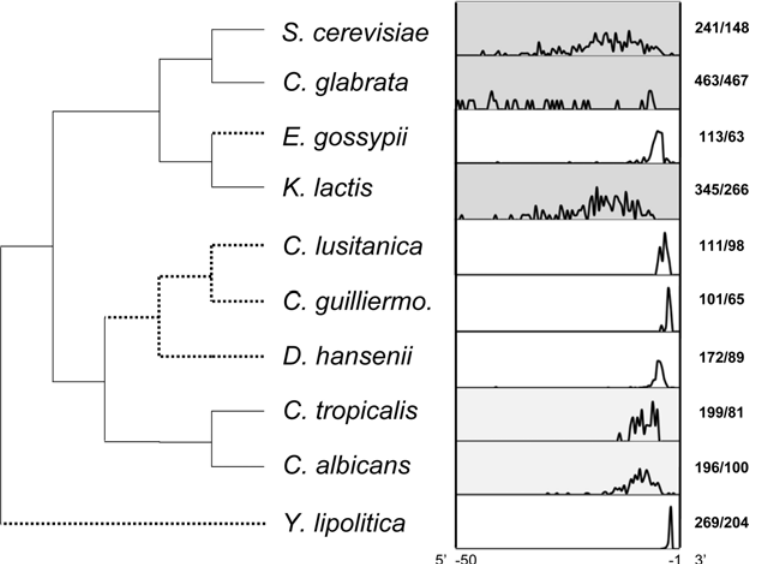
Figure 5. Phylogenetic distribution of BP-AG distance across hemiascomicetous yeasts. For each species, the distribution represents the fraction of introns with a certain distance to the AG from base -50 (most left) to base -1 (most right, terminal G). Grey background highlights relative lack of constraint BP-AG distance, and broken lines show the lineages that likely experienced the evolution of BP-AG distance constraint.